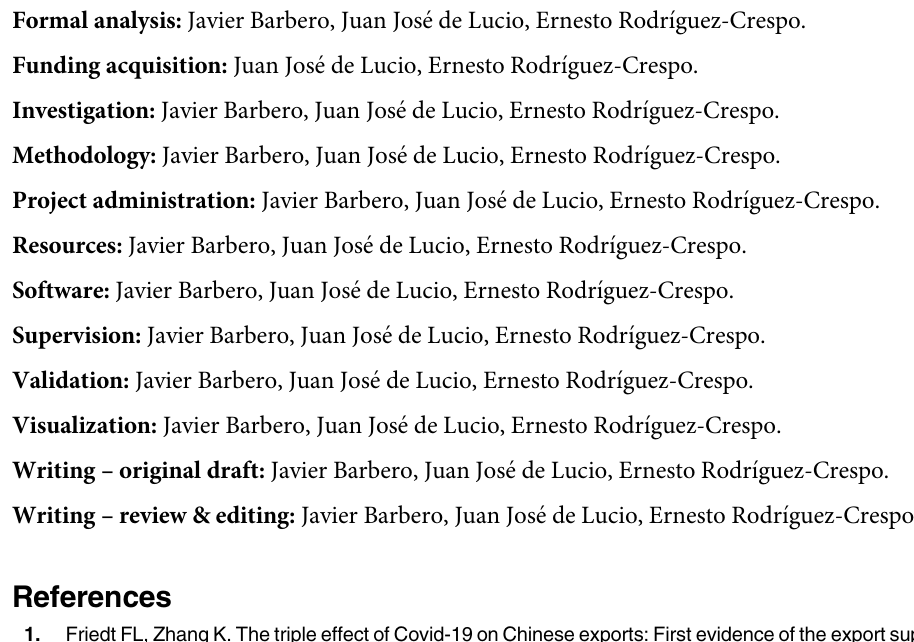
S5 Table. One lag of COVID-19 government response indicator. Results by income levels. Estimated by PPML, January 2019–October 2020. Dependent variable is exports. Robust stan- dard errors in parentheses, such as ��� p < 0.01, �� p < 0.05, � p < 0.1. Each COVID-19 indicator is estimated on a different regression but paired in the same column for the sake of brevity. All the specifications include exporter-month, importer-month and pair fixed effects. S6 Table. Robustness: Imports, M. Results by income levels and COVID-19 indicators esti- mated by PPML, January 2019-October 2020. Dependent variable is imports. Robust stan- dard errors in parentheses, such as ��� p < 0.01, �� p < 0.05, � p < 0.1. Each COVID-19 indicator is estimated on a different regression but paired in the same column for the sake of brevity. All the specifications include exporter-month, importer-month and pair fixed